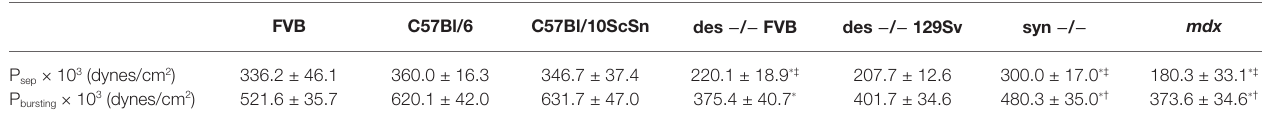
TABLE 1 | Average of P sep and P bursting expressed as mean ± SD from all SLs